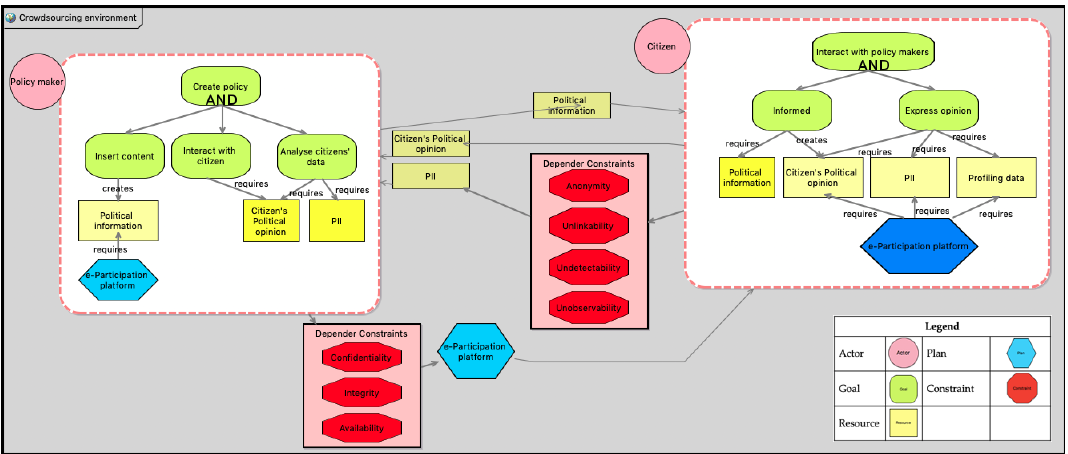
Figure 2. Crowdsourcing environment